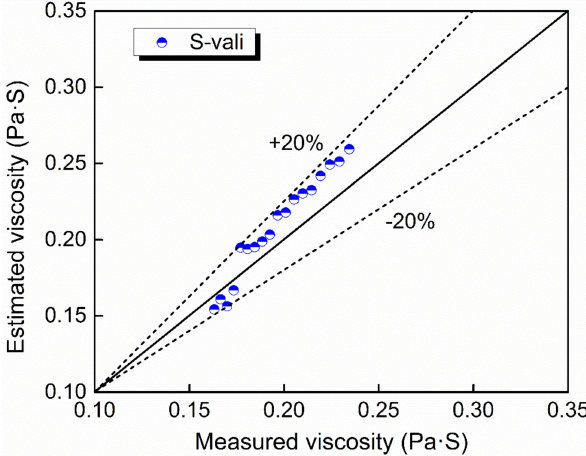
Figure 13. The estimated viscosity against the measured viscosity of S-vali using the modified NPL